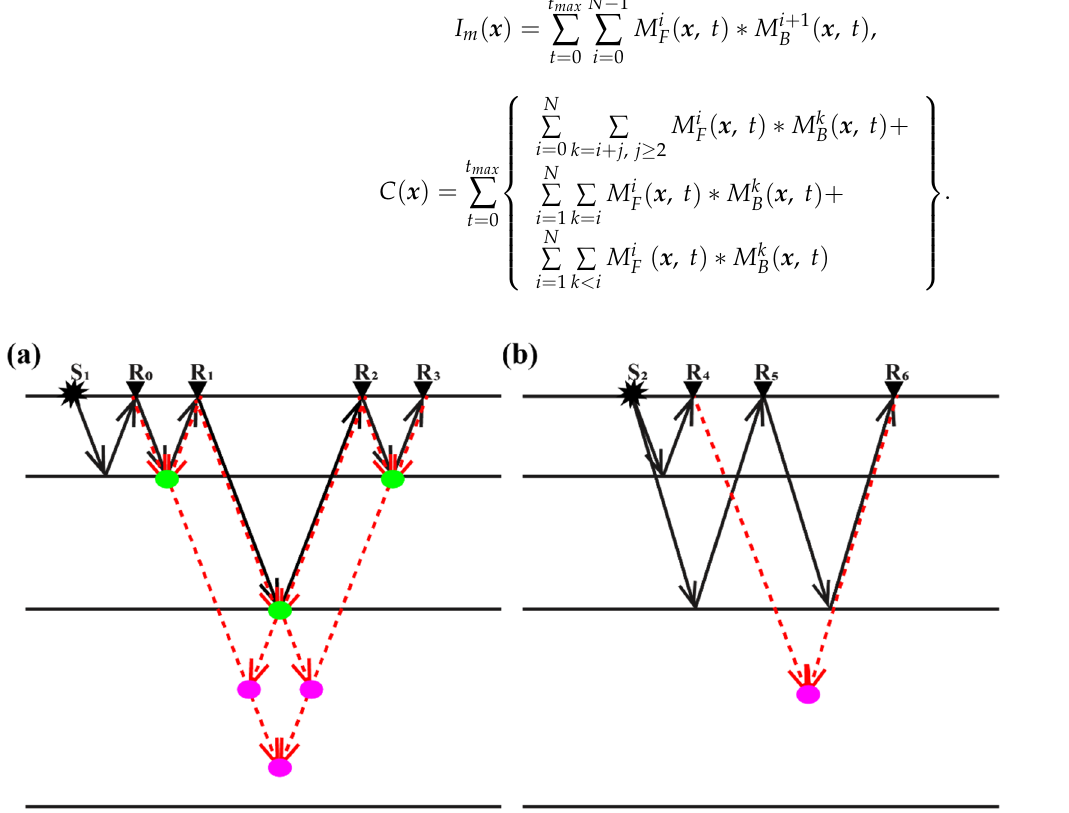
Figure 1. Schematic diagrams of RTMM and crosstalks. The green points in panel ( a ) represent the imaging points. The magenta points in panels ( a , b ) represent the order-related and event-related crosstalks, respectively.